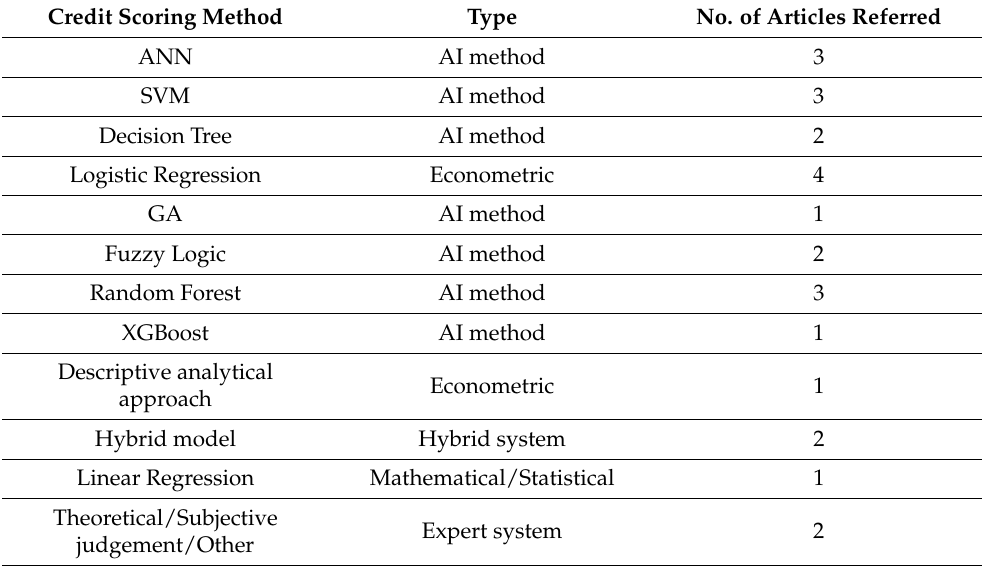
Table 2. Different credit scoring methods referred from reviewed works of literature in this study.